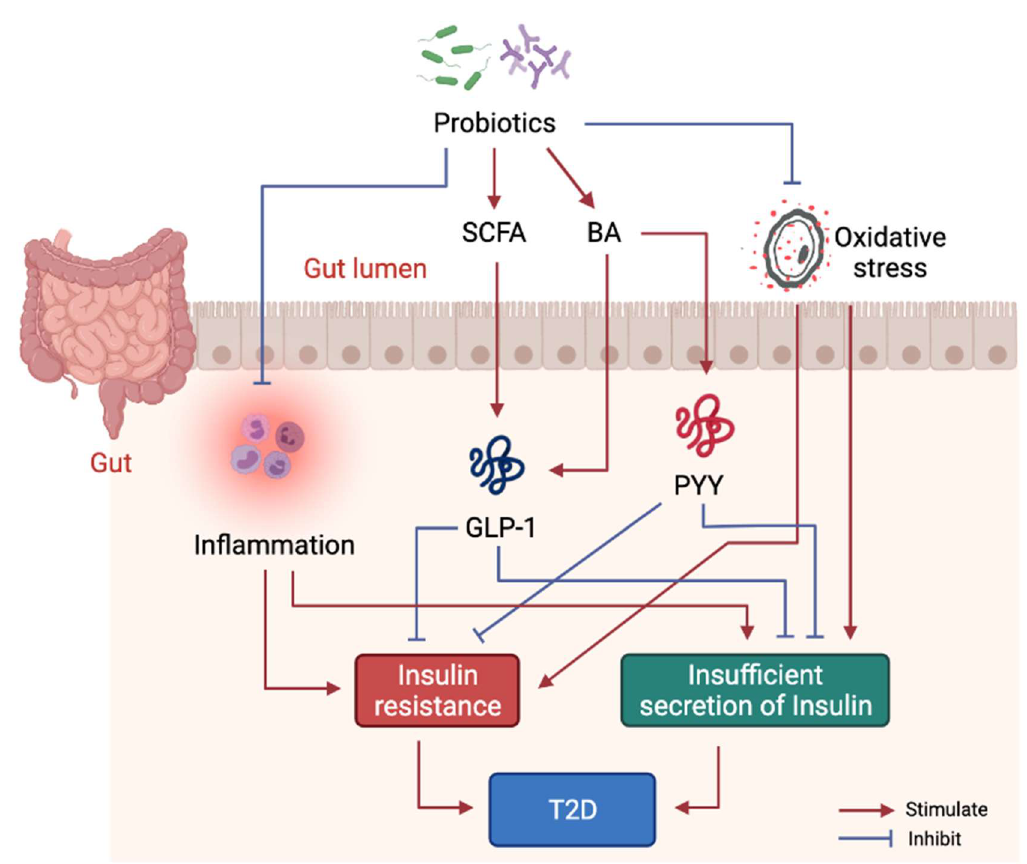
Figure 3. Molecular mechanism of probiotics intervention on T2D. Probiotics in gut help produce beneficial metabolites including SCFA and some BA to stimulate GLP-1 and PYY secretion, thus, to alleviate insulin resistance and dysfunction of insulin secretion. Probiotics also suppress systemic inflammation by modulating gut microbiota structure.